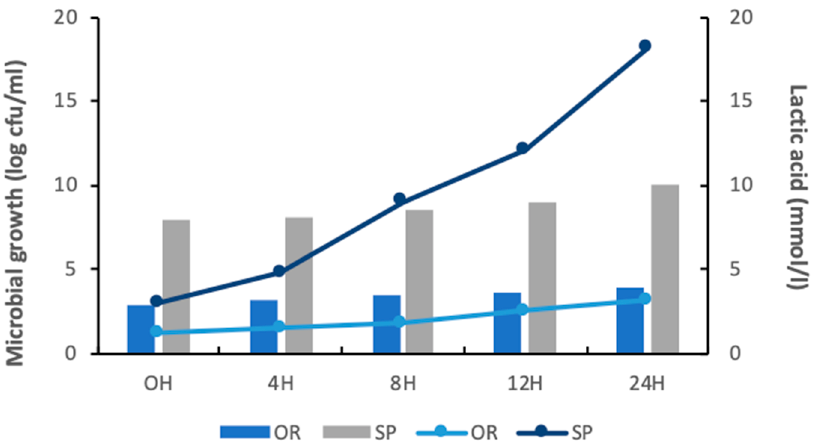
Figure 1. Microbial growth (log cfu/mL) and formation of lactic acid (mmoL/L) in spontaneously fermented sourdough (OR) and sourdough fermented with Lactobacillus spicheri DSMZ 15429 (SP) during 24 h of fermentation.